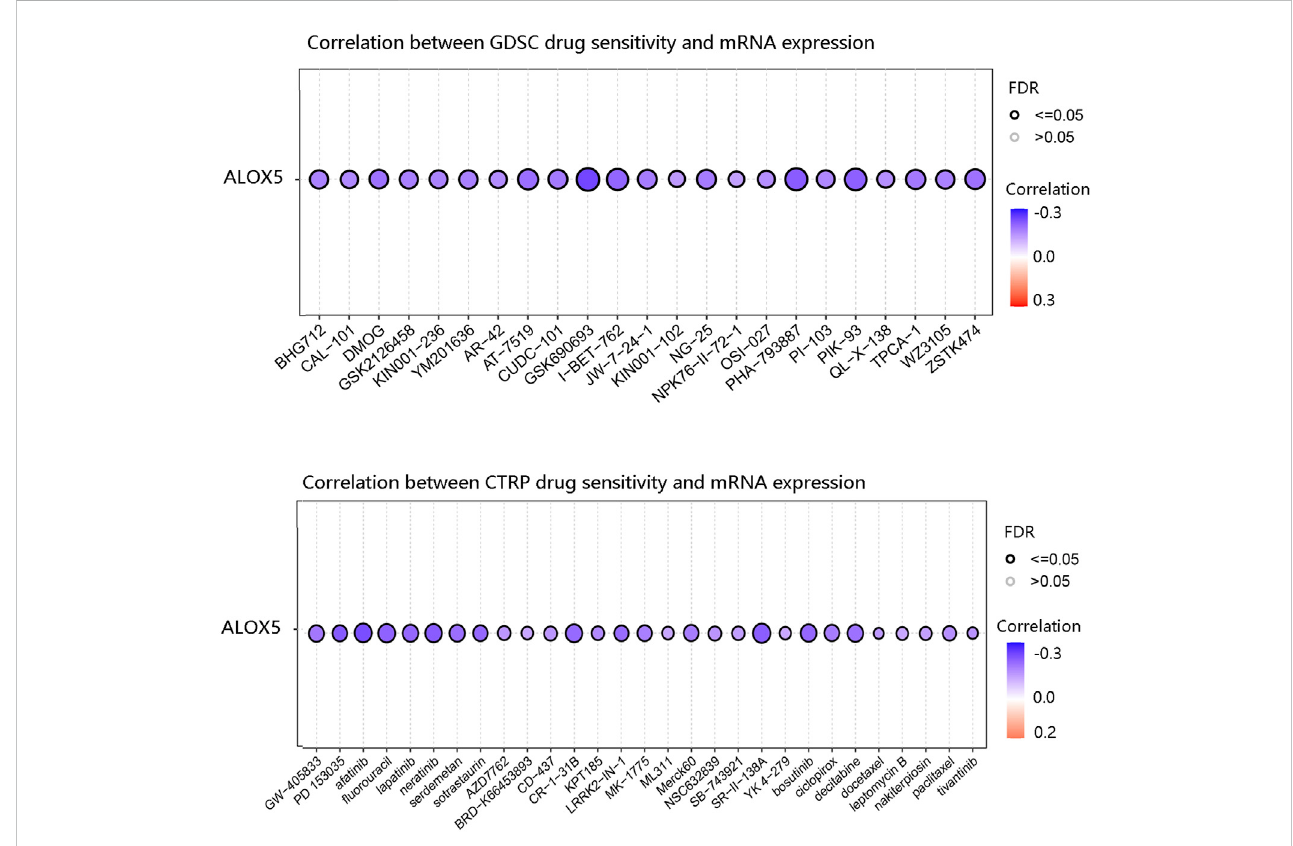
FIGURE 12 The negative correlation between ALOX5 expression and drug sensitivity based on GDSC and CTRP in the GSCA